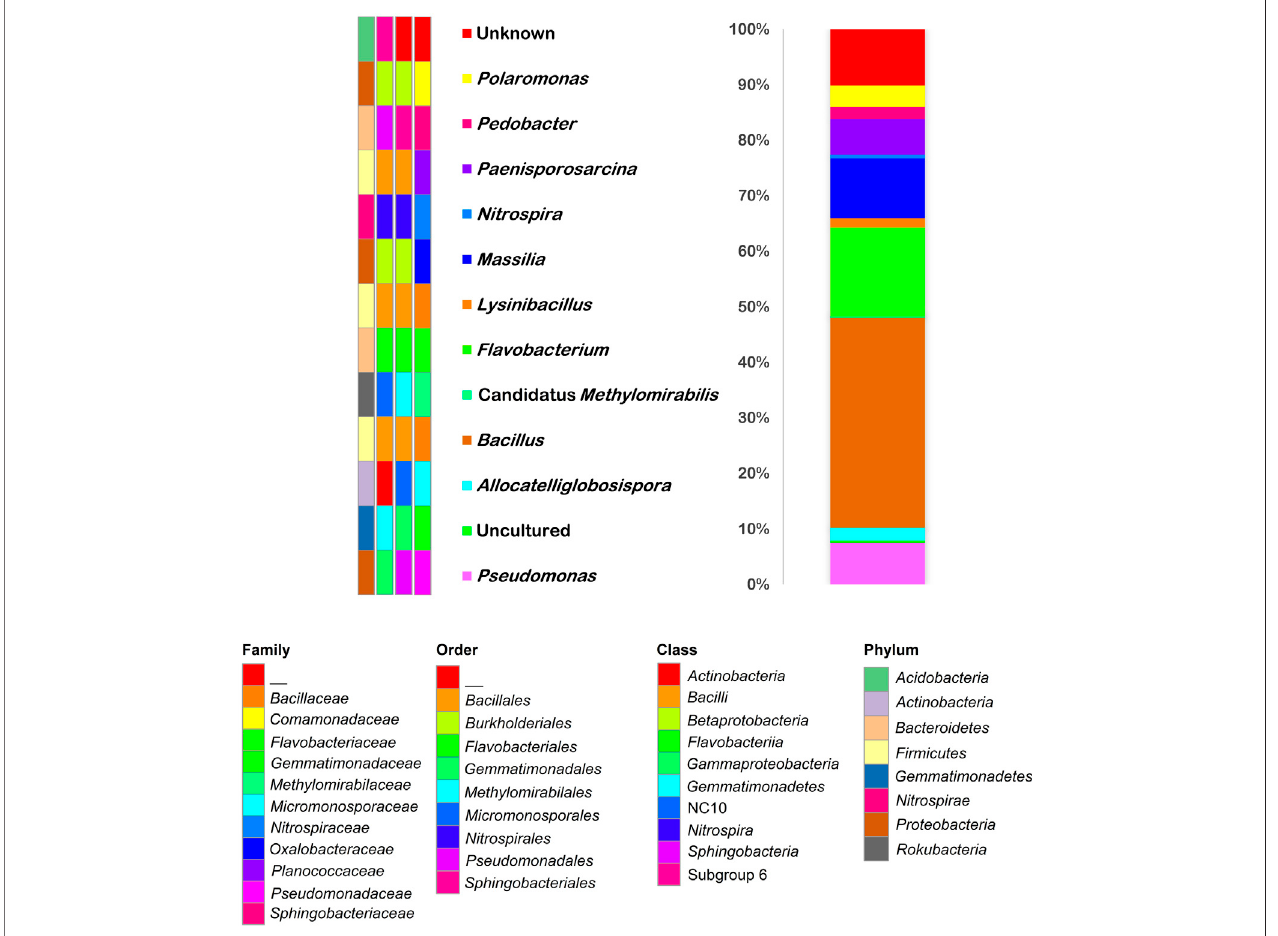
FIGURE10| TaxonomybarplotofmicrobialcommunitycompositionoftheFe-Mnpatinasample.Thecolorchangesinthebarplotshowthepercentagesoccupied by genera (color keys on the left). Taxa assignments (P, phylum; C, class; O, order; F, family) are indicated by the color keys on the bottom.